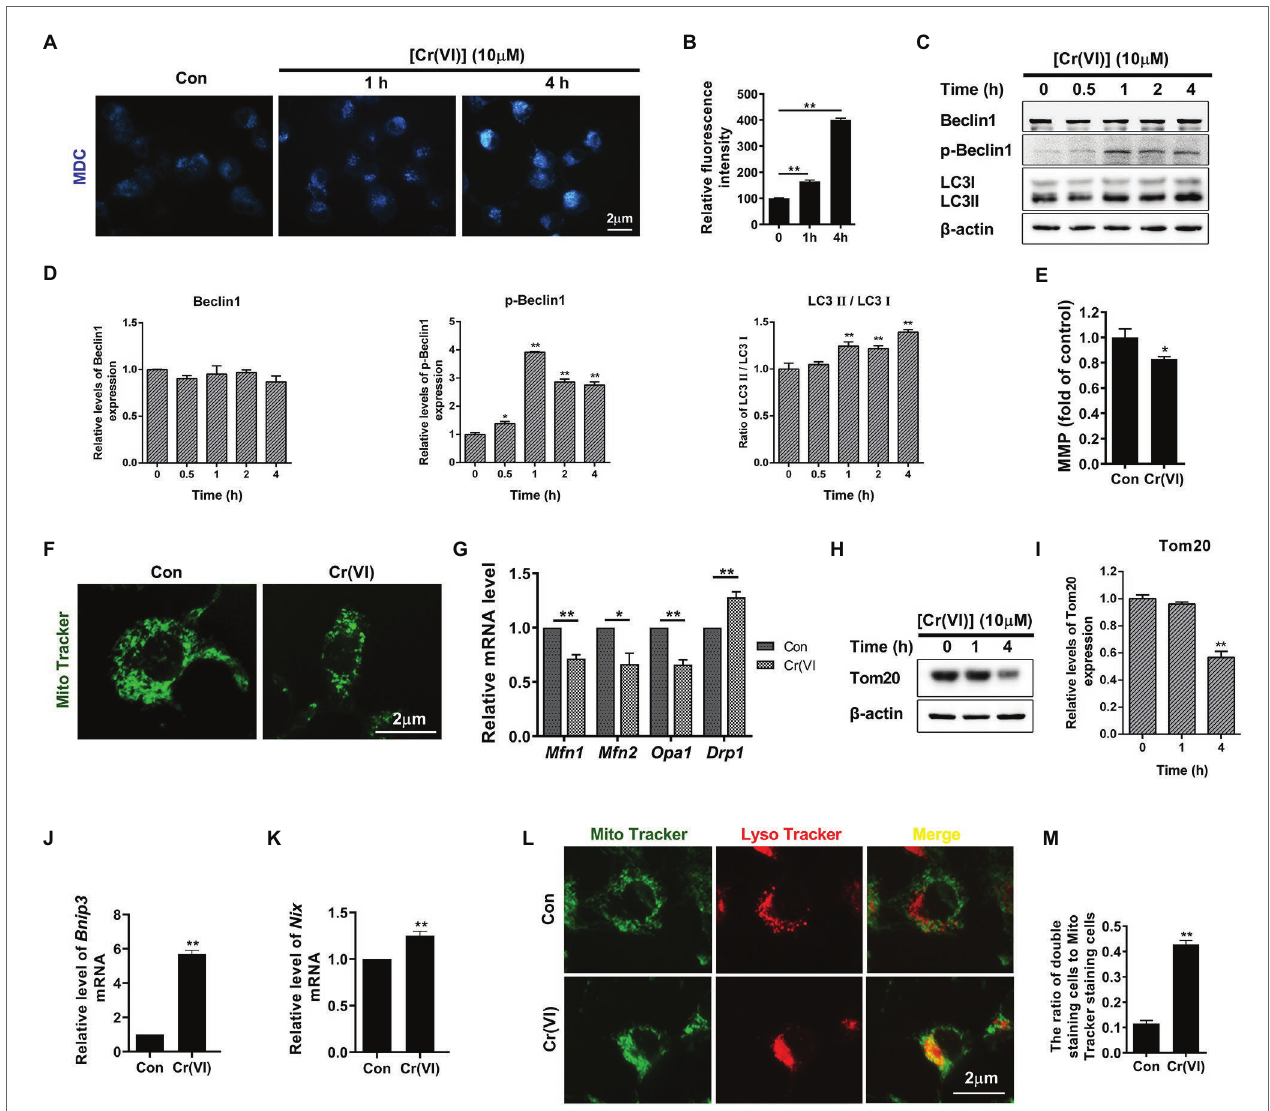
FIGURE 3 | Chromium (VI) induced mitochondrial dynamic imbalance and mitophagy in SSCs/progenitors. (A) Monodansylcadaverine (MDC) staining for autophagic vacuoles. Bar = 2 μ m. (B) The relative fluorescence intensity of MDC in SSCs/progenitors treated with 10 μ M Cr (VI) for different time. (C) Western blot analysis of the expression levels of autophagy markers Beclin1, p-Beclin1, and LC3 in SSCs/progenitors treated with 10 μ M Cr (VI) for different time. β -actin is used as a loading control. (D) The relative band intensities of Beclin1, p-Beclin1, and LC3-II in different cell treatment groups. (E) Mitochondrial membrane potential (MMP) in SSCs/progenitors treated with vehicle or 10 μ M Cr (VI) for 4 h, as detected by the lipophilic cationic dye JC-1. (F) Mito Tracker staining for mitochondria in SSCs/progenitors treated with vehicle or 10 μ M Cr (VI) for 4 h. Bar = 2 μ m. (G) qPCR analysis of Mfn1 , Mfn2 , Opa1 , and Drp1 in SSCs/progenitors treated with vehicle or 10 μ M Cr (VI) for 4 h. (H) Western blot analysis of Tom20 in SSCs/progenitors treated with 10 μ M Cr (VI) for different time. β -actin is used as a loading control. (I) The relative band intensities of Tom20 in different cell treatment groups. (J,K) qPCR analysis of Bnip3 (J) and Nix (K) in SSCs/progenitors treated with vehicle or 10 μ M Cr (VI) for 4 h. (L) Mito and Lyso Tracker co-staining analysis in SSCs/progenitors treated with vehicle or 10 μ M Cr (VI) for 4 h. Bar = 2 μ m. (M) The ratios of double staining cells to Mito Tracker staining cells in the control and 4 h of 10 μ M Cr (VI) treatment group. Data are presented as the mean ± SEM of three independent experiments. * p < 0.05; ** p <